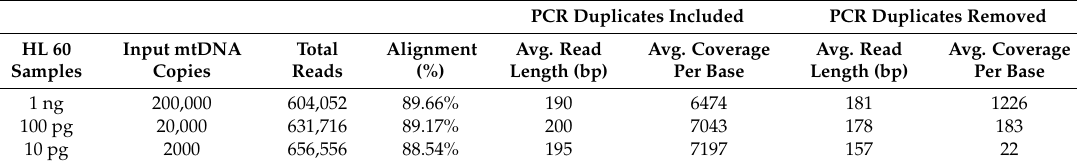
Table 2. Sequencing statistics of mitochondrial DNA sensitivity study samples.